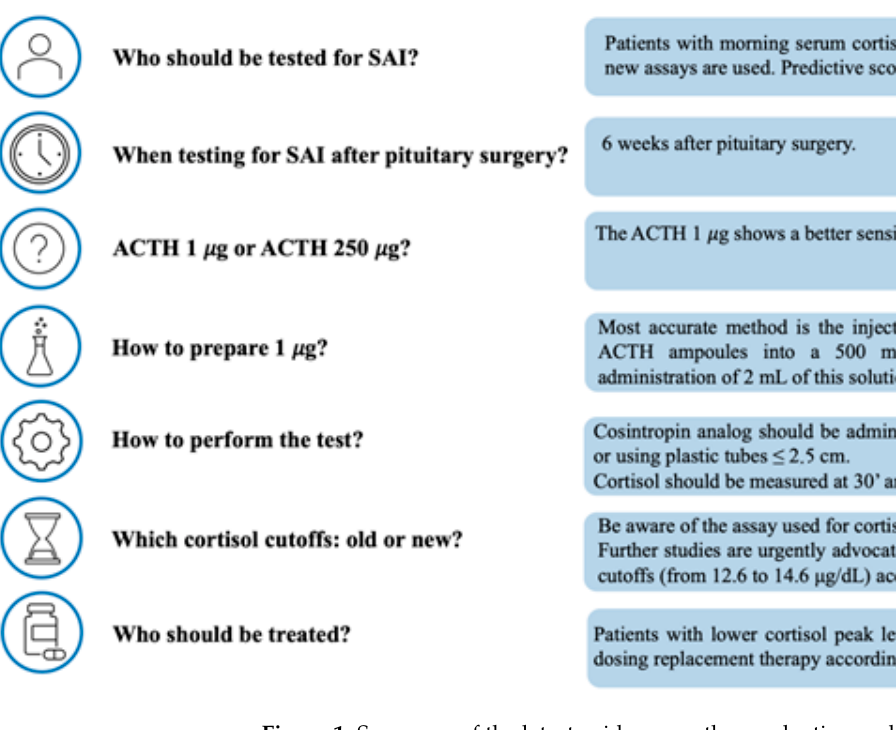
Figure 1. Summary of the latest evidence on the conduction and interpretation of the ACTH test for the diagnosis of SAI. The range of new cutoffs proposed in the figure are from studies conducted using Elecsys Cortisol generation II assay.